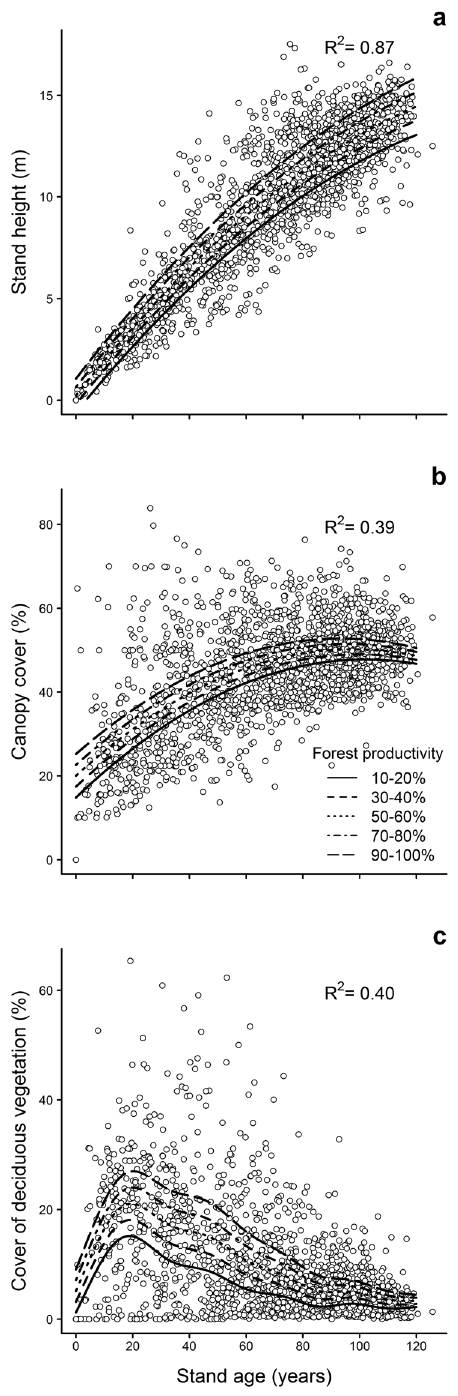
Figure 1. ( a ) Stand height, ( b ) total canopy cover, and ( c ) canopy cover comprised of deciduous vegetation, as a function of their age for five categories of proportions of potentially productive stands (forest productivity) in eastern Canadian boreal forest. The lines are estimated from the models that are presented in Supplementary Tables S1 and S2, and, accordingly, the influence of productivity on all three stand attributes varies significantly with